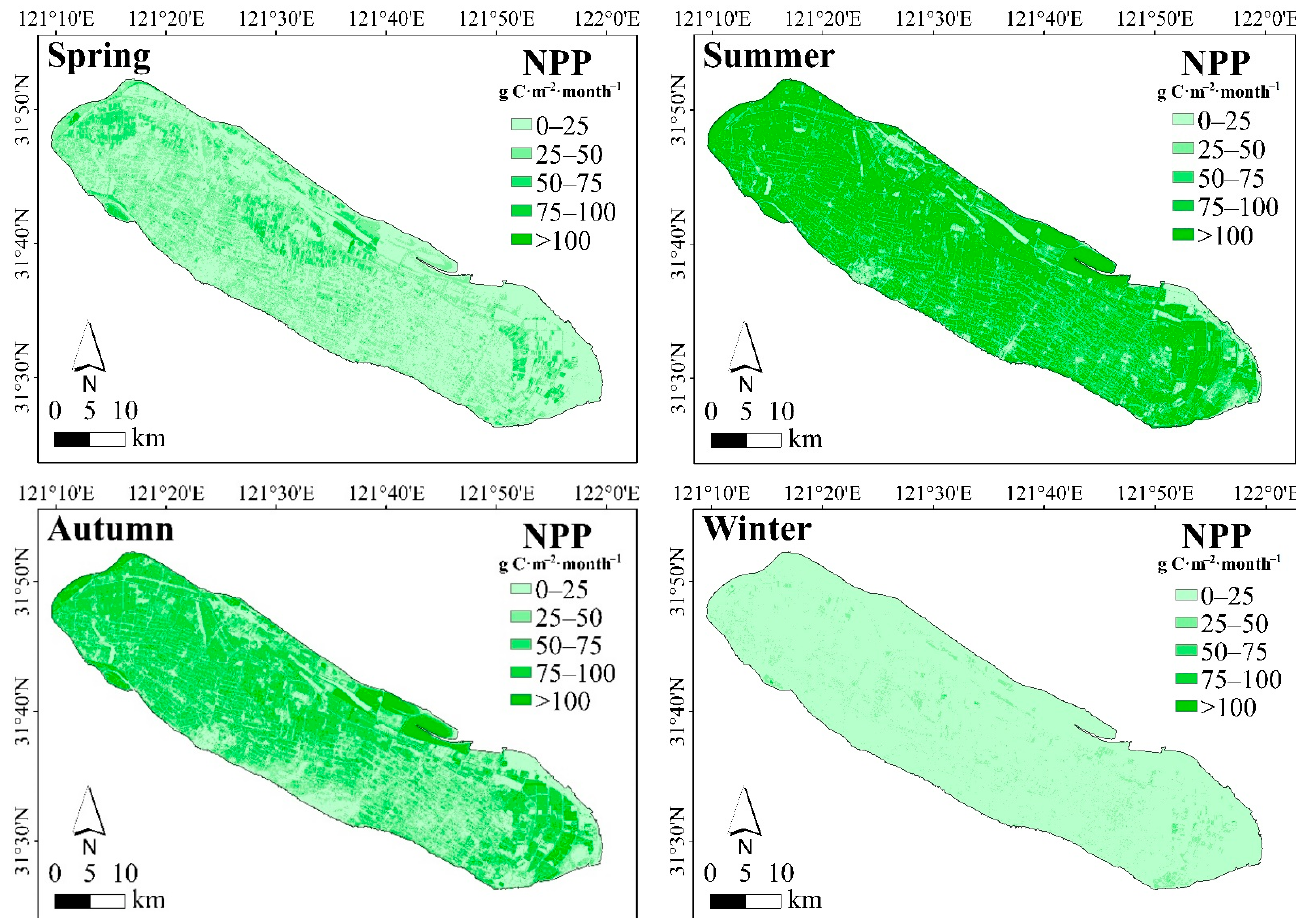
Figure 6. Spatiotemporal characteristics of vegetation NPP in different seasons of 2016–2017.